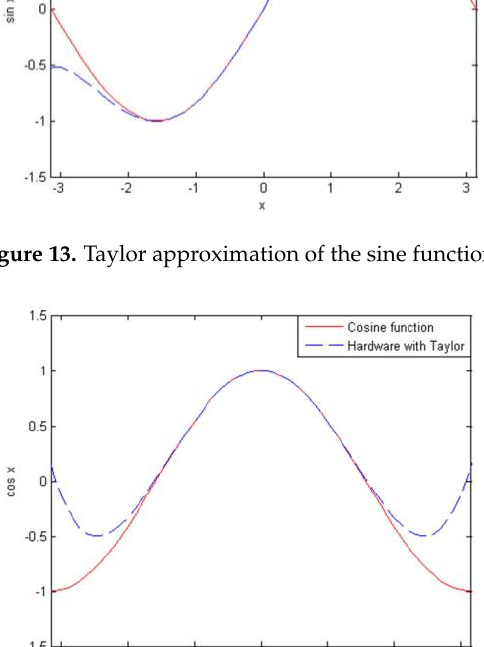
Figure 15. Block diagram of the sine function with the Taylor expansion and LUT.